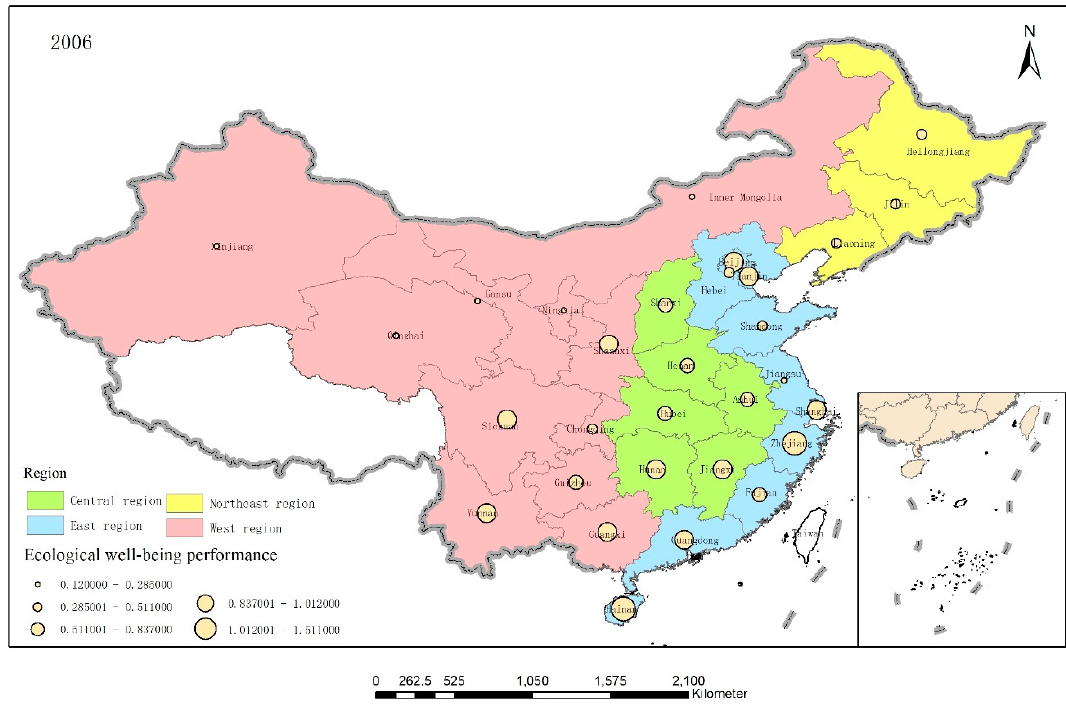
Figure 5. The EWP distributions in the 30 provinces in 2006.